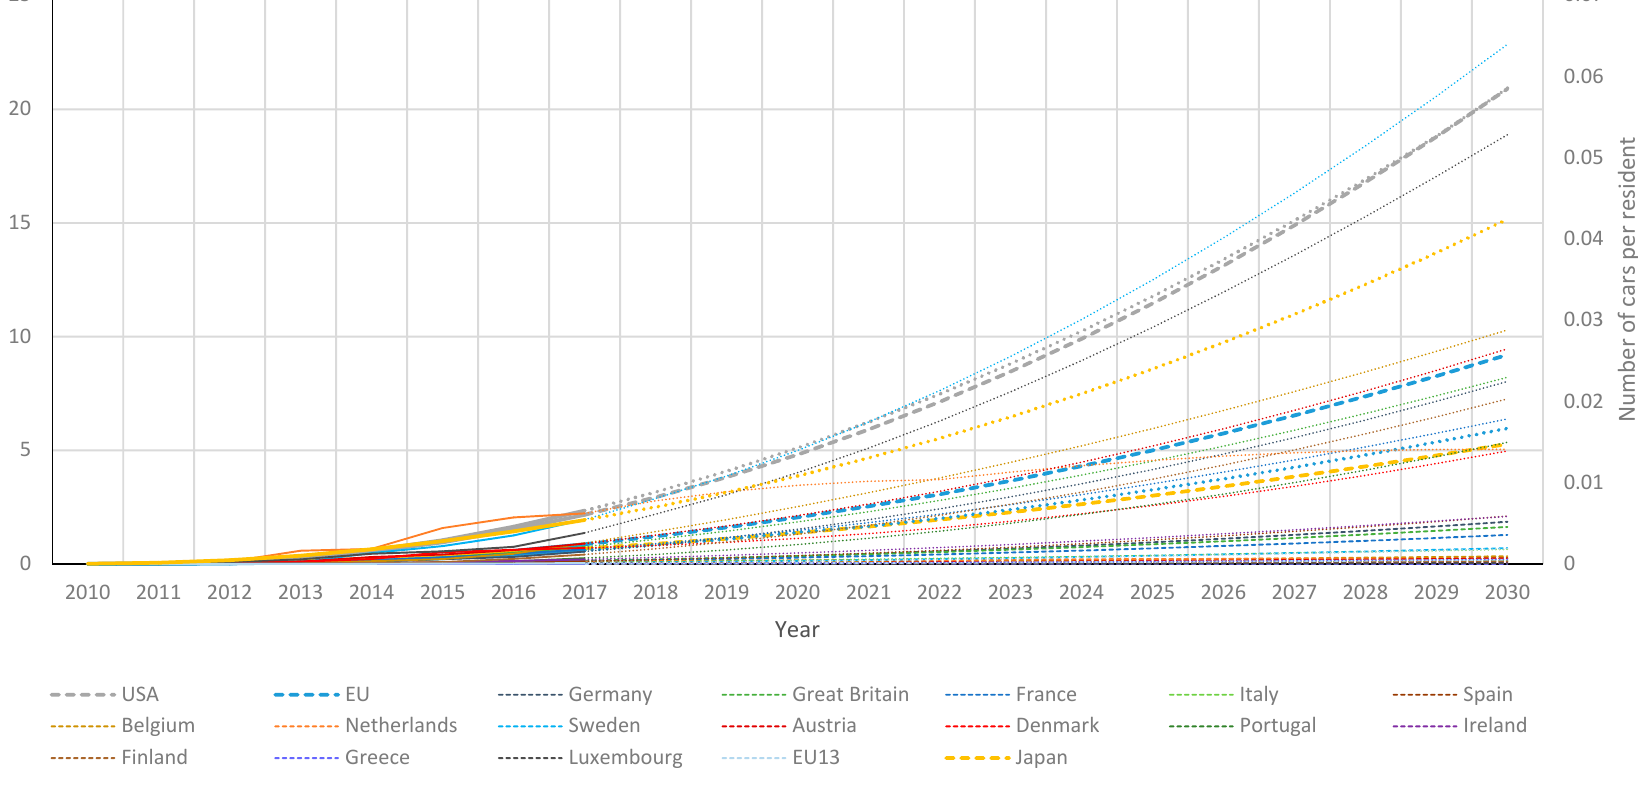
Figure 3. Aggregated number of electric cars in the European Union, United States and Japan, including forecast until 2030 and relation of the absolute number of electric cars to the number of residents, including forecast until 2030 [own calculations].